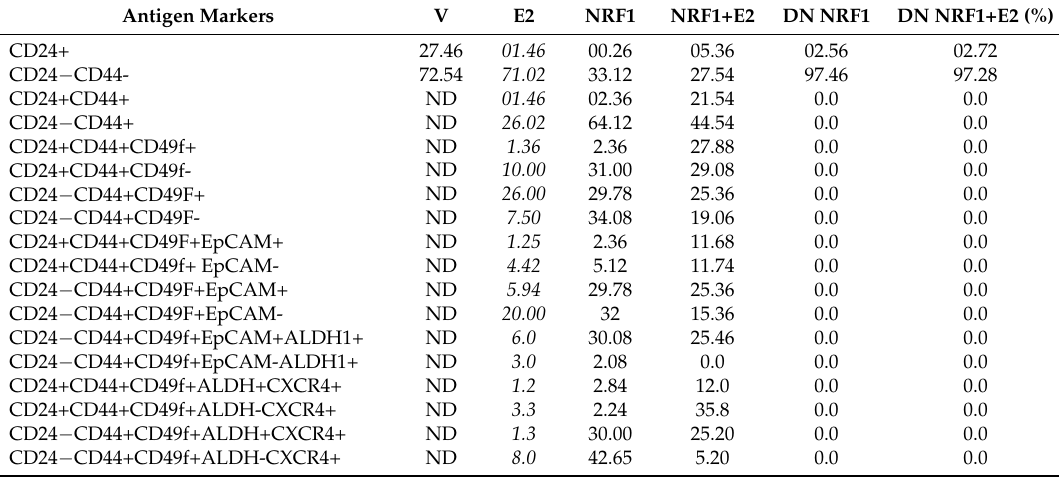
Table 1. Stochastic generation of different cell subpopulations of BCSCs separated by flow sorting by the CD24 − CD44+ and CD49f, ALDH1, EPCAM, CD133, CXCR4 and NRF1 phenotypes. 17 β -estradiol (E2), NRF1+E2, dominant negative (DN) NRF1 and DN NRF1+E2 treated breast epithelial MCF10A cells were immunostained with CD24 and CD44 antibodies, and subsequently with CD49F, ALDH1, EPCAM, CD133, and CXCR4. The cell subpopulations defined by the CD24 − CD44+ and other antigens phenotypes were separated by fluorescence-activated cell sorting (FACS). The percentages (%) shown in the table show the representation of the cell subpopulations in the total transformed by E2 and/or NRF1 or vector (V) transfected parental cell